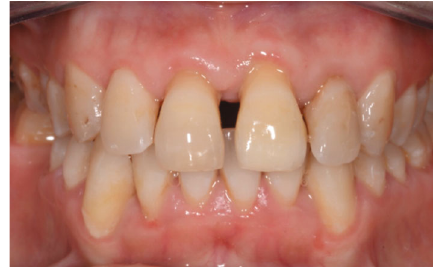
Figure 7: 4-week posttrauma.